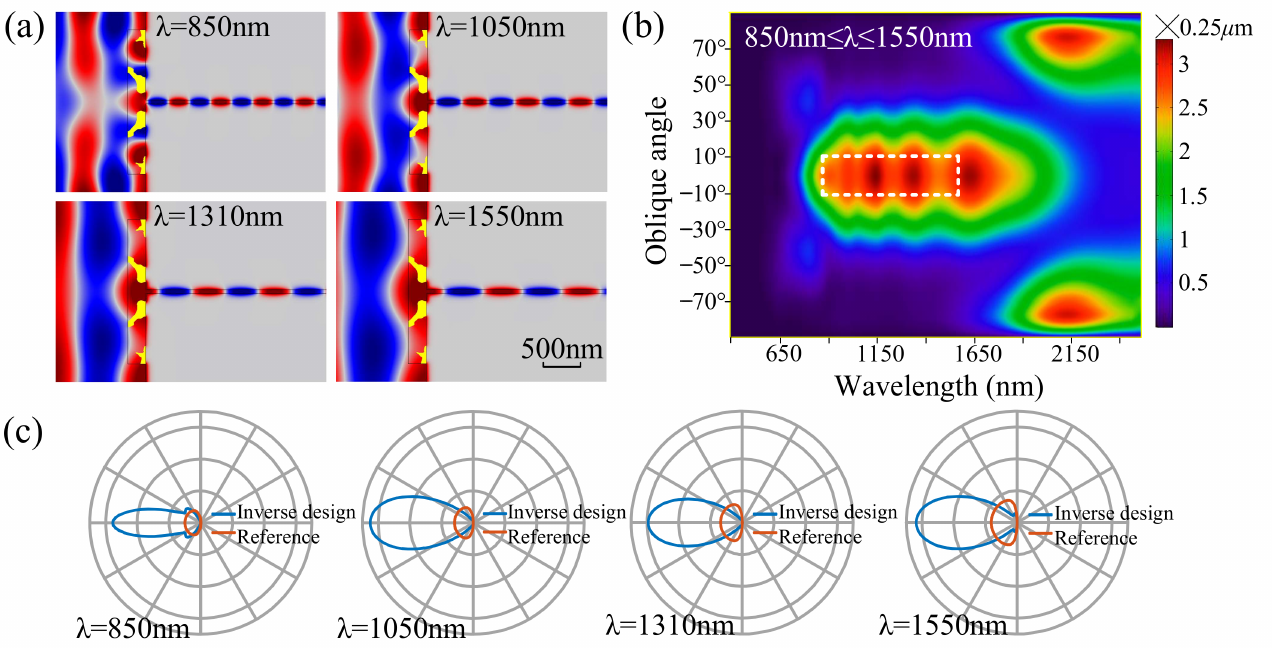
Figure 2. ( a ) Inversely designed MIM simultaneously working for the four communication wavelengths. ( b ) Effective- aperture spectrum of the inversely designed nanoantenna shown in Figure 2a. ( c ) Polar diagrams of the nanoantenna for the four communication wavelengths shown in Figure